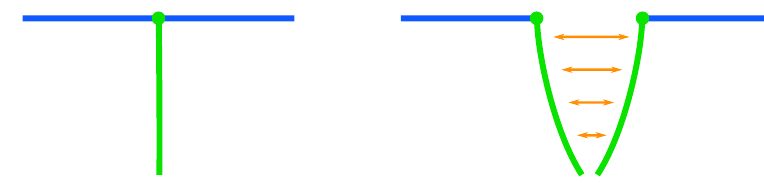
Figure 13 . Left: in the brane perspective, the bath CFT on the asymptotic boundary (blue) is connected to two copies of the e(cid:11)ective CFT on the brane (green) but the resulting geometry is not a manifold. Right: for excitations below the e(cid:11)ective CFT cuto(cid:11) the system behaves as if it consists of two systems on a manifold which are weakly coupled in the gravitational region